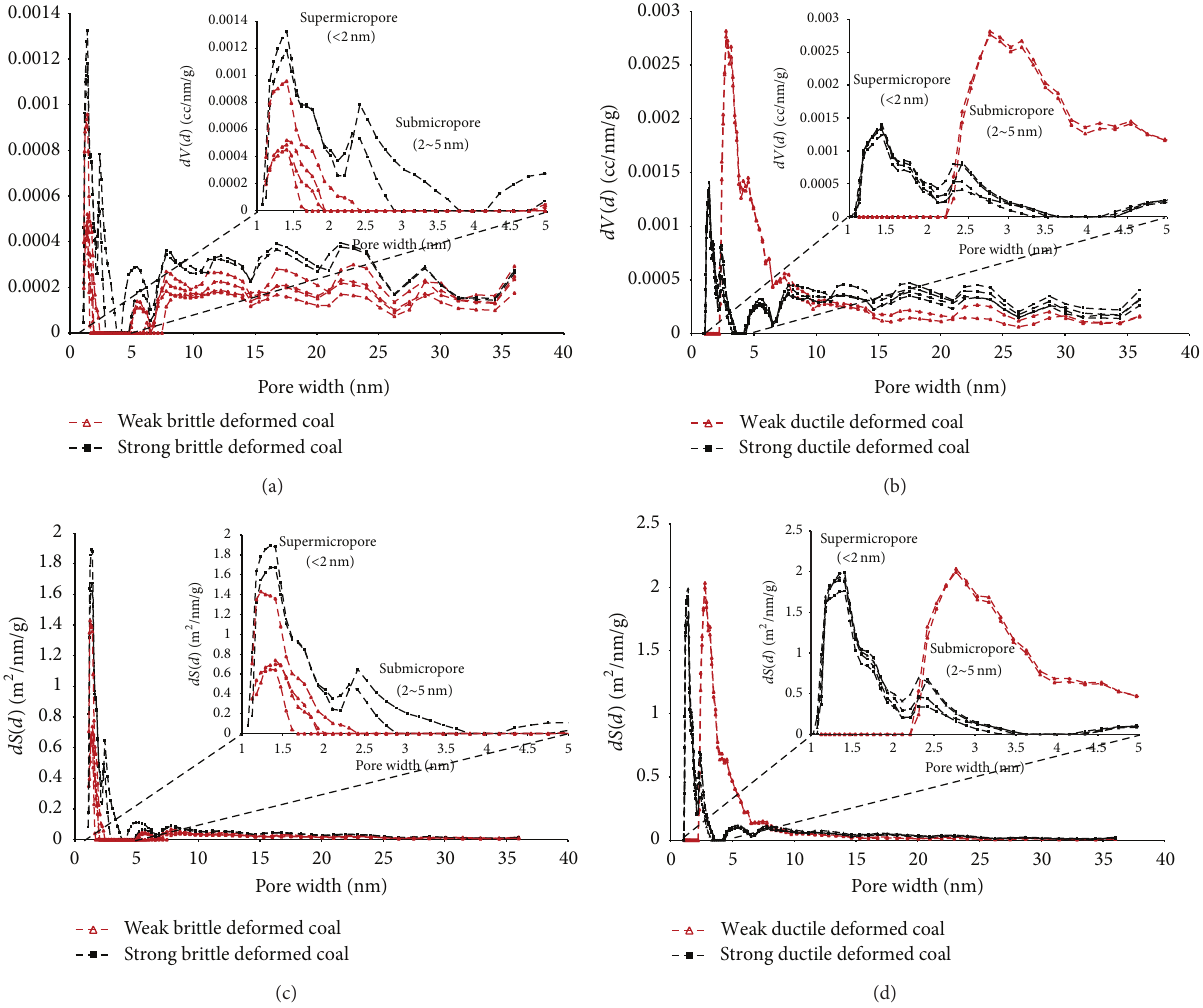
Figure 8: Nanopore distribution of deformed coals with different deformational intensity; (a, c) brittle deformed coal; (b, d) ductile deformed